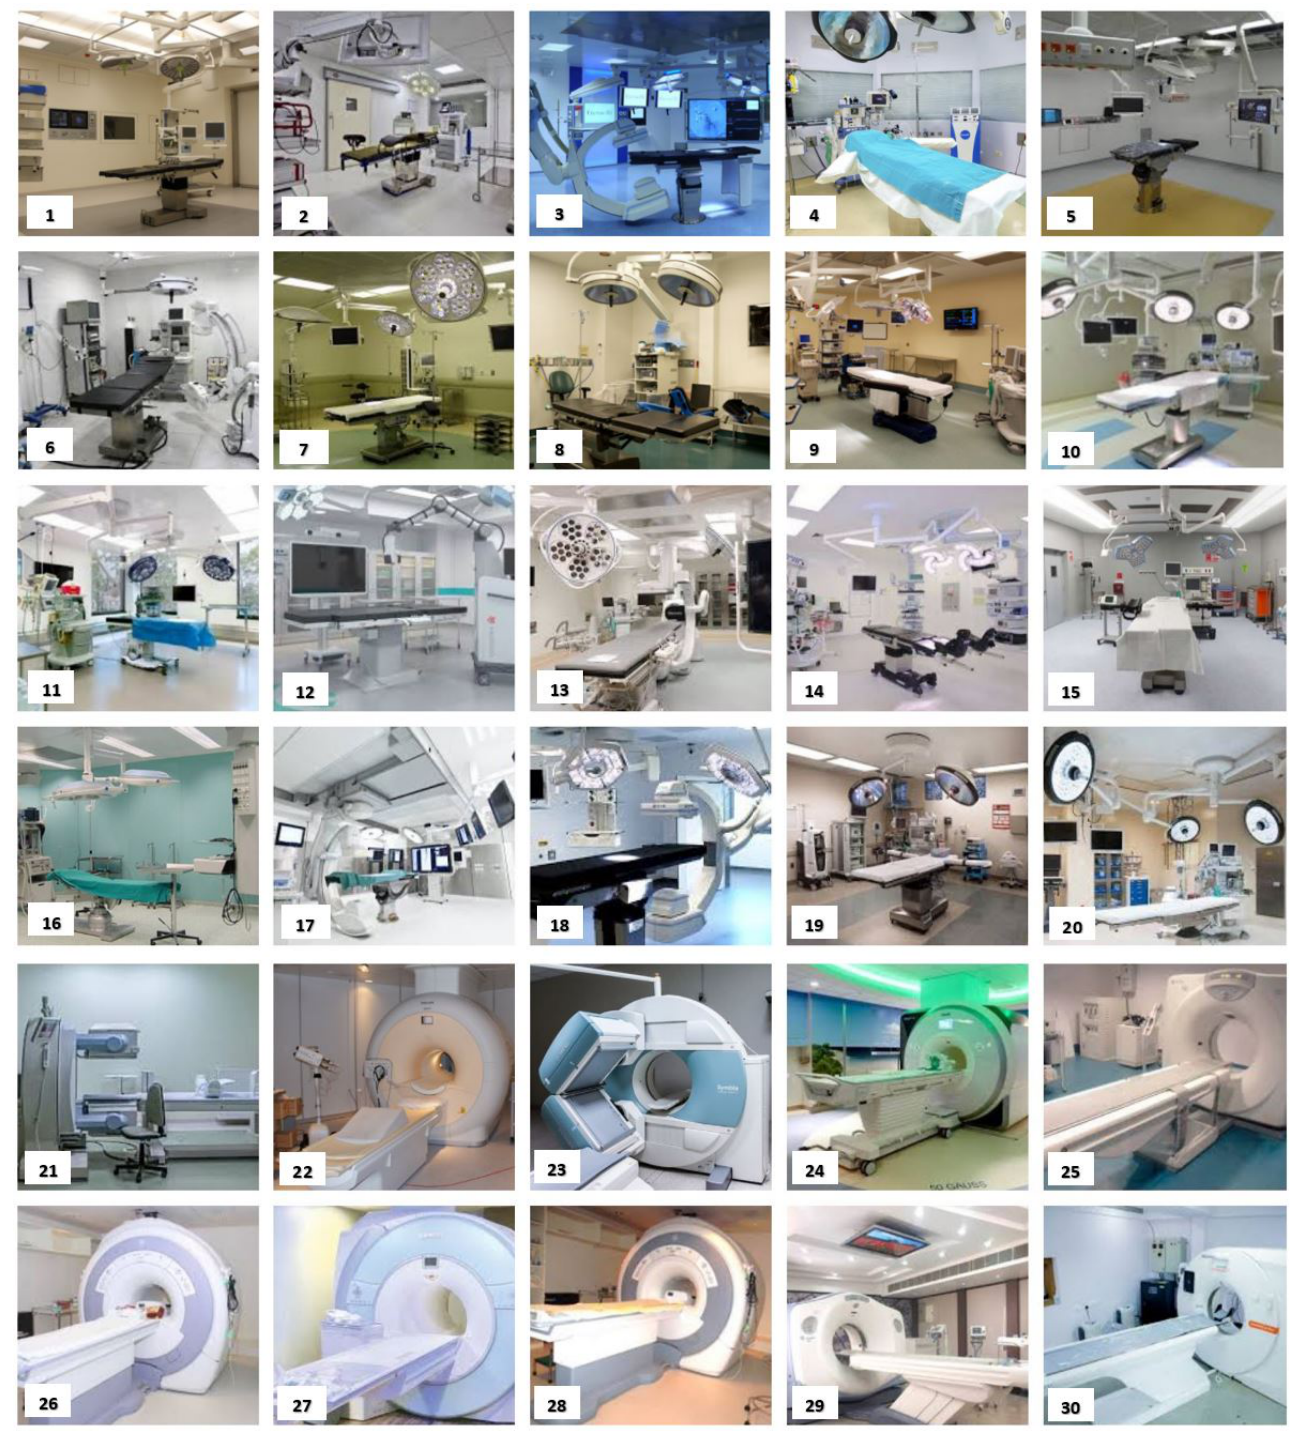
Figure A1. The images used in the training sets (1 to 10) and test sets (11 to 20) of both custom models for the “surgery” IU and the images used in the training sets (21 to 30) of both custom models for the “diagnostic and therapeutic radiology” IU (from Google